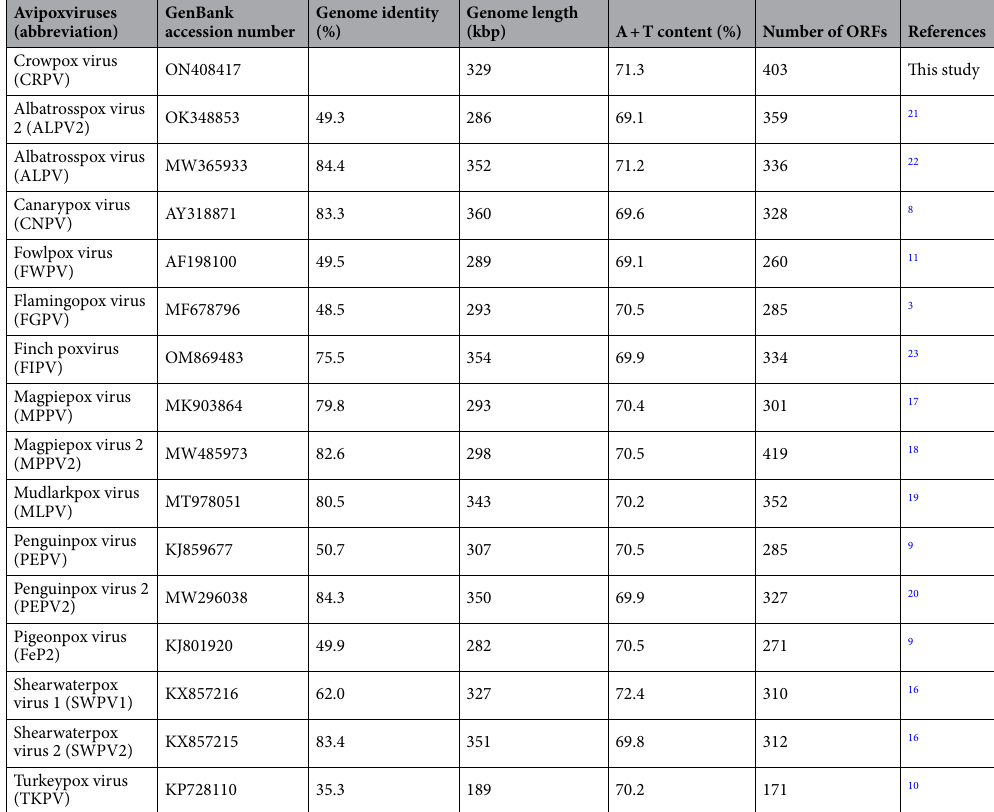
Table 1. Comparative analysis of representative avipoxviruses and CRPV based on complete genome nucleotide